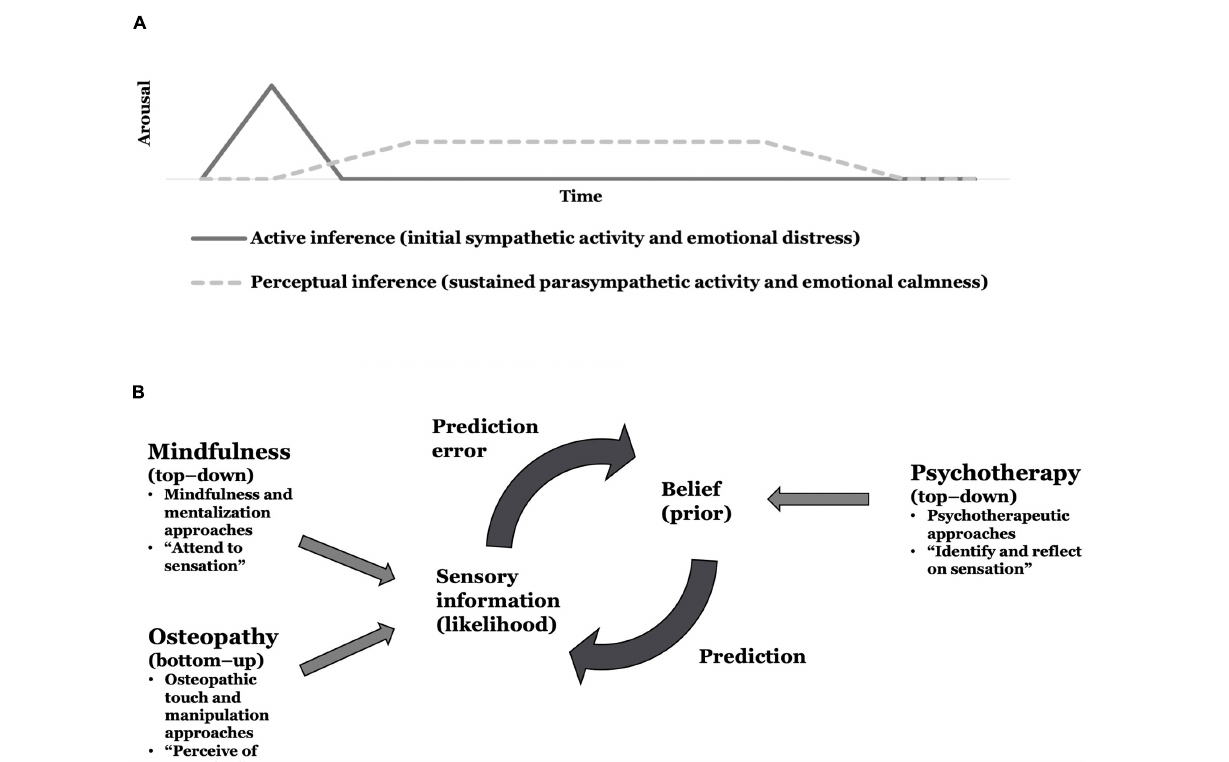
Frontiers in Psychology |